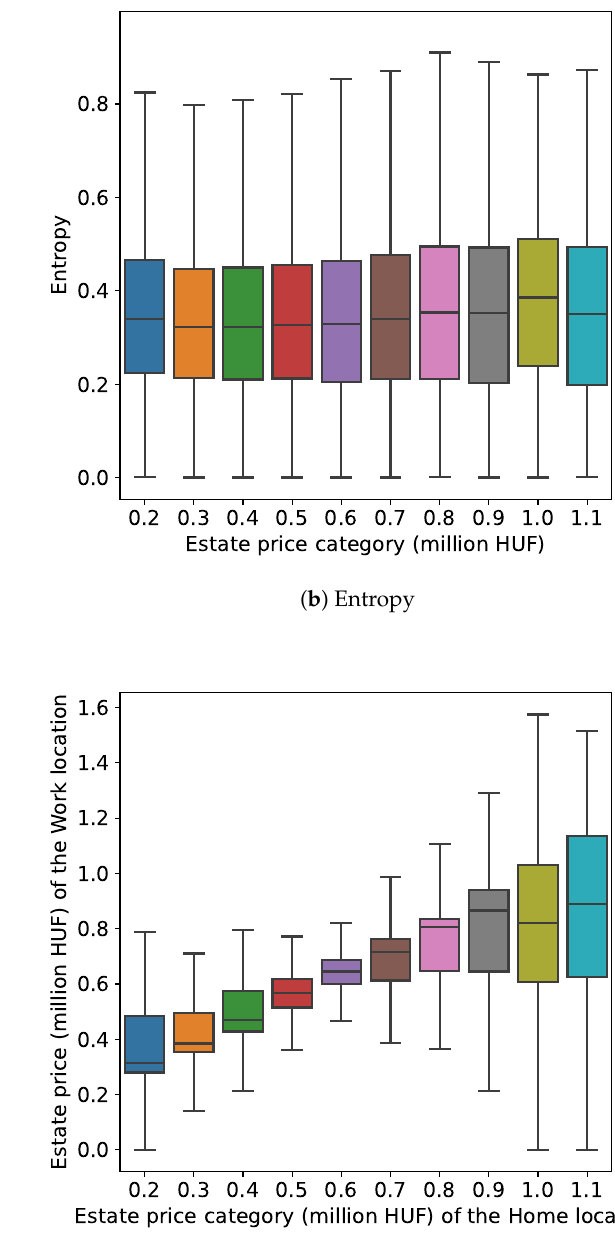
( d ) Estate prices of the work locations in contrast to the workers’ home location estate prices Figure 7. Indicators by financial